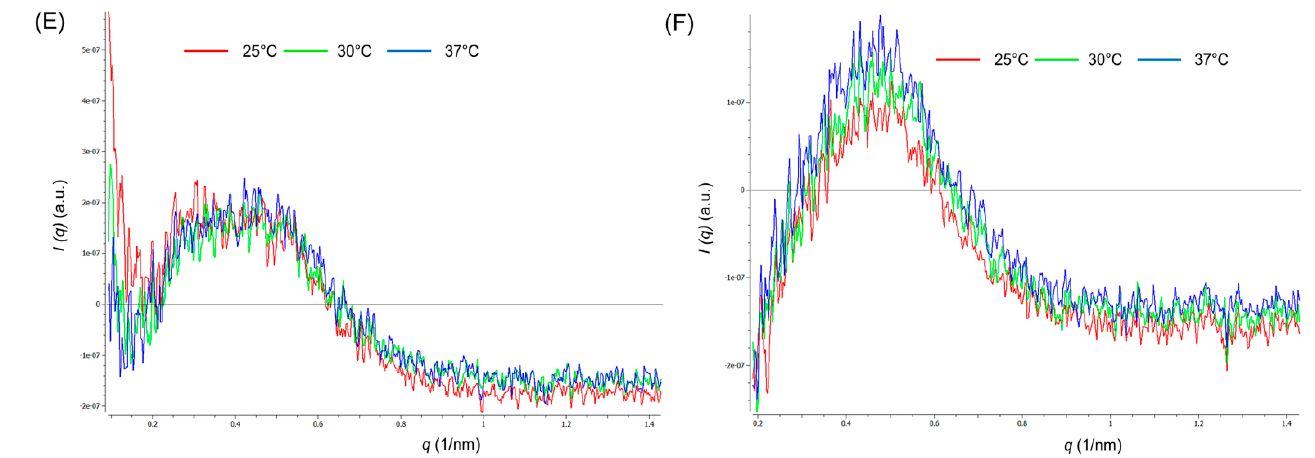
Figure 1. SAX structure of fluocinolone acetonide polymeric micelles (FPMs) 1 ( A ), 2 ( B ), 7 ( C ), 8 ( D ), 13 ( E ), and 14 ( F ) for all temperatures as 25 °C, 30 °C and 37 °C.